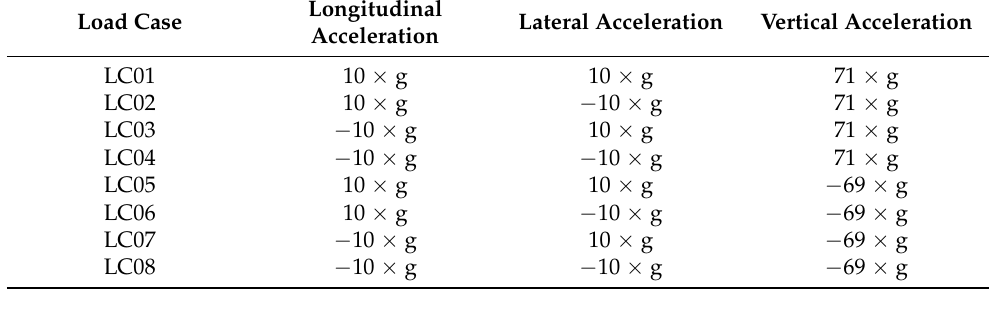
Table 3. Combined load cases of static strength.